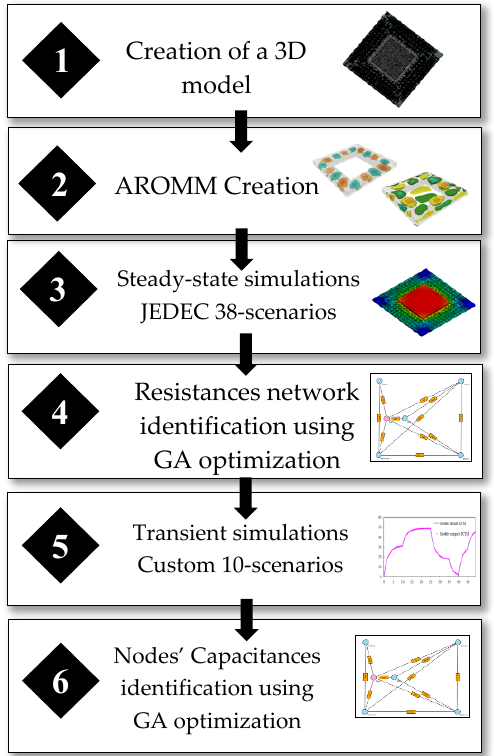
Figure 7. Hybrid dynamic compact thermal model (DCTM) creation flow.